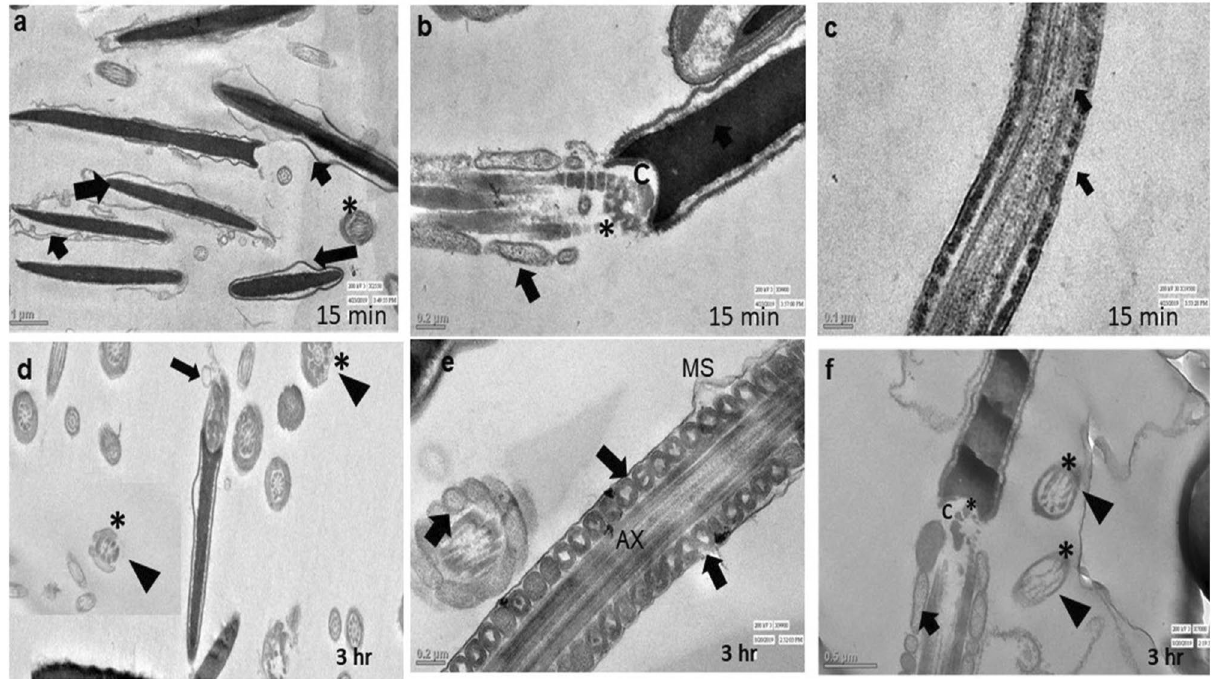
Figure 9. Transmission electron microscopic images of goat spermatozoa exposed to 1.25 µg/ml HgCl 2 showing ultra-structural defects. ( a ) swollen sperm head membrane (arrow), ( b ) collapsed mitochondria (arrow); bent neck (star); disrupted connection between nucleus and midpiece by centriole ( c , b , f ), ( c ) outer dense fibers (arrow), ( d ) damaged head membrane (arrow); damaged axoneme membrane (triangle; ( d , f )), ( e ) mitochondria (arrow); axoneme (AX; arrow); damaged mitochondrial sheath (MS; ( e )),collapsed mitochondria (arrow; ( f )); disorganized exoneme (star; ( f )) after 15 and 3 h.